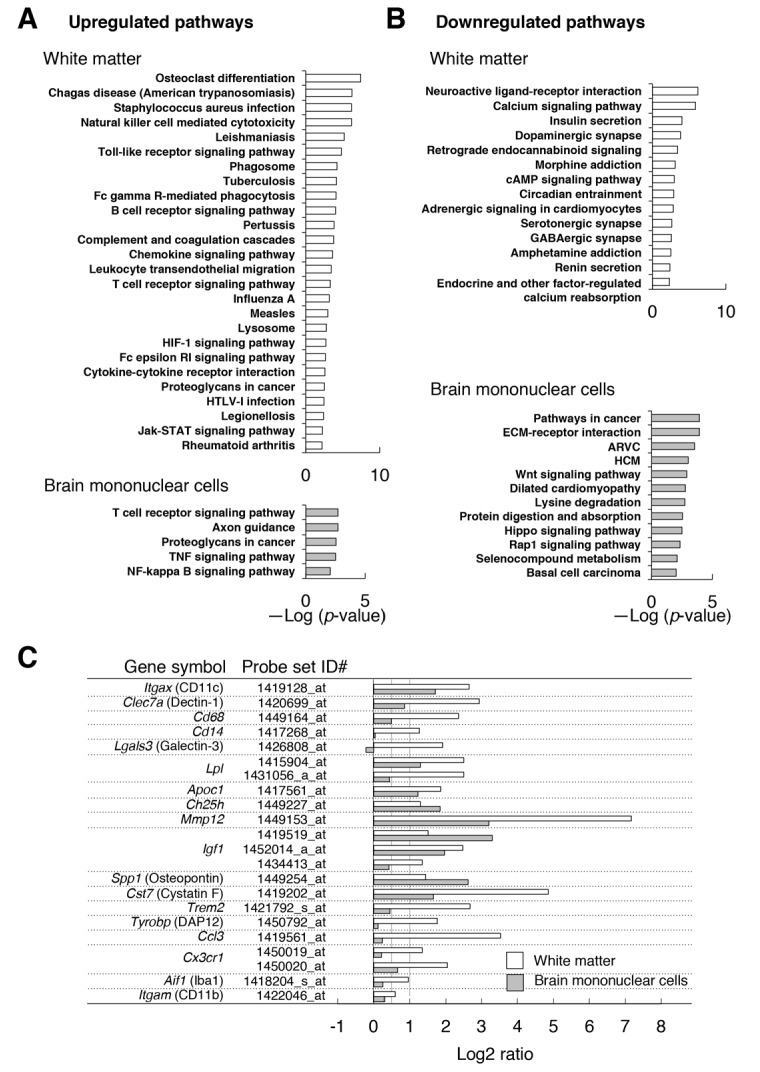
Microarray transcriptome analyses of the white matter and the brain mononuclear cells of CD47 KO mice.(A,B) The results of Kyoto Encyclopedia of Genes and Genomes (KEGG) pathway analysis with DAVID. Statistically significant (p-value <0.01) KEGG enrichment pathways of up- (A) or downregulated (B) genes in the white matter (optic nerve and optic tract) (upper panels) or in the brain mononuclear cells (lower panels) of CD47 KO mice. Enrichment score is expressed as –Log (p-value). ARVC, Arrhythmogenic right ventricular cardiomyopathy; HCM, Hypertrophic cardiomyopathy. (C) The expression changes of selected genes that are characteristic of microglia or of de- and re-myelination processes. For each probe set on the microarray, the fold-change of gene expression in the CD47 KO mice compared with WT mice was expressed as a log2 ratio. Open and filled bars represent data for white matter and the brain mononuclear cells, respectively. Probe set ID#: Affymetrix probe set ID number for Mouse 430 2.0 Gnome Arrays.